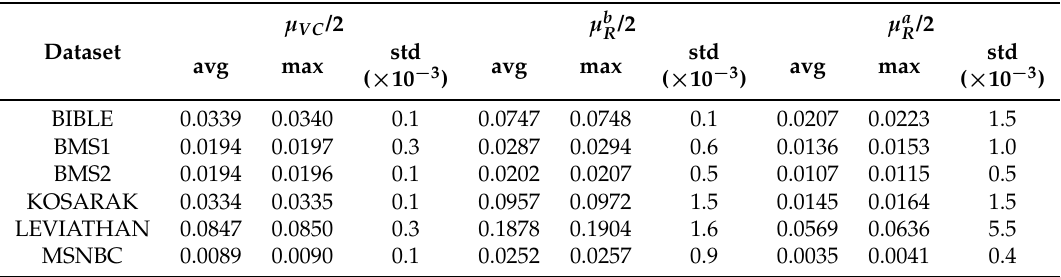
Table 4. Comparison of the upper bound µ /2 to the maximum deviation achieved respectively by ComputeMaxDevVC, ComputeMaxDevRadeBound, and ComputeMaxDevRadeApprox for each dataset. We show averages avg , maximum values max , and standard deviations std for each dataset and method over the 4 pseudo-artificial